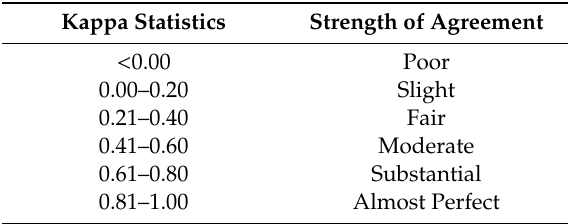
Table 3. Kappa Statistics and Strength of Agreement